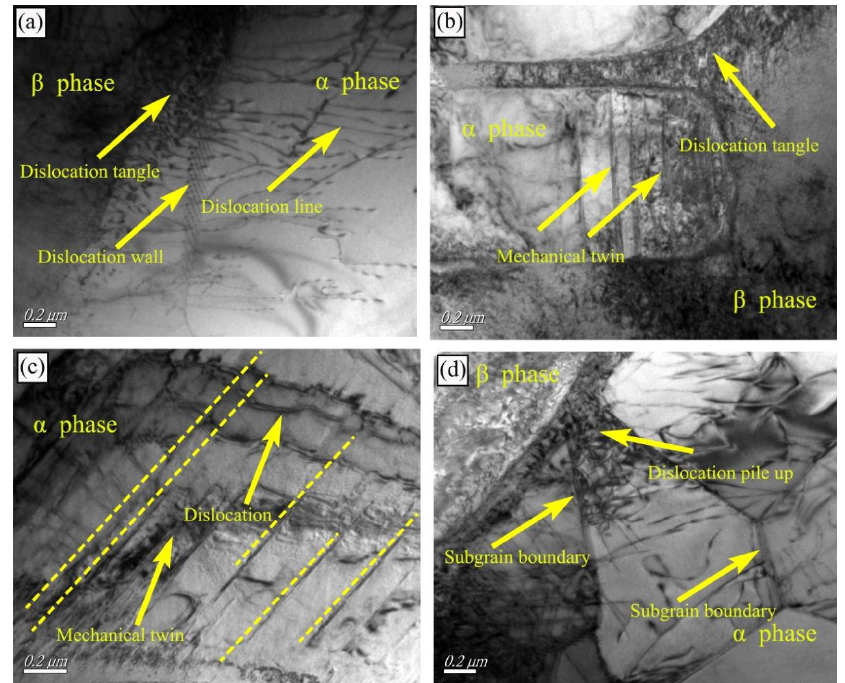
Figure 5. Microstructure characteristics after different numbers of laser pulse impacts. ( a ) Single impact: Parallel dislocation lines are observed in the α phase and high density of dislocation tangles are formed in the β phase. ( b ) 3 impacts: mechanical twins are found in the α phase while dense dislocations in the β phase. ( c ) 5 impacts: plenty of twins are induced in the α phase. ( d ) 10 impacts: a high density of dislocations exists at the grain boundaries and the original coarse grains are divided in to